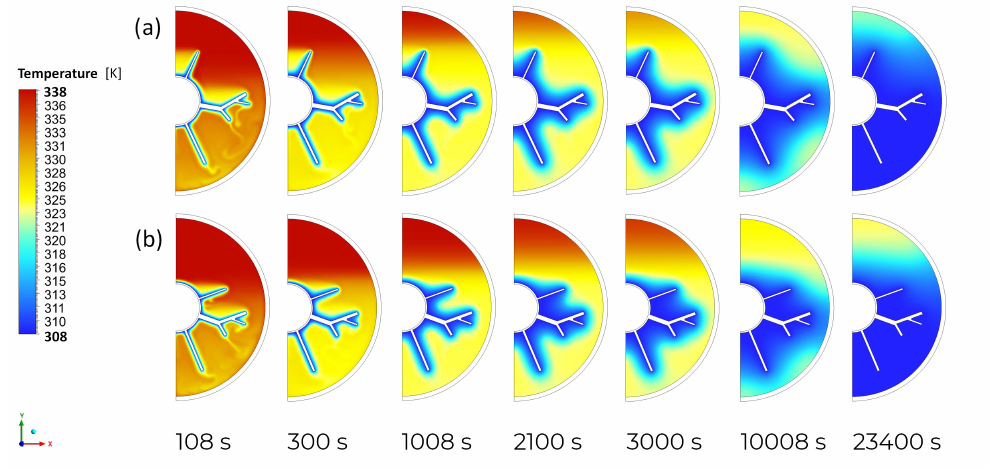
Figure 10. Temperature field during solidification for ( a ) DP No. 15, ( b ) DP No.